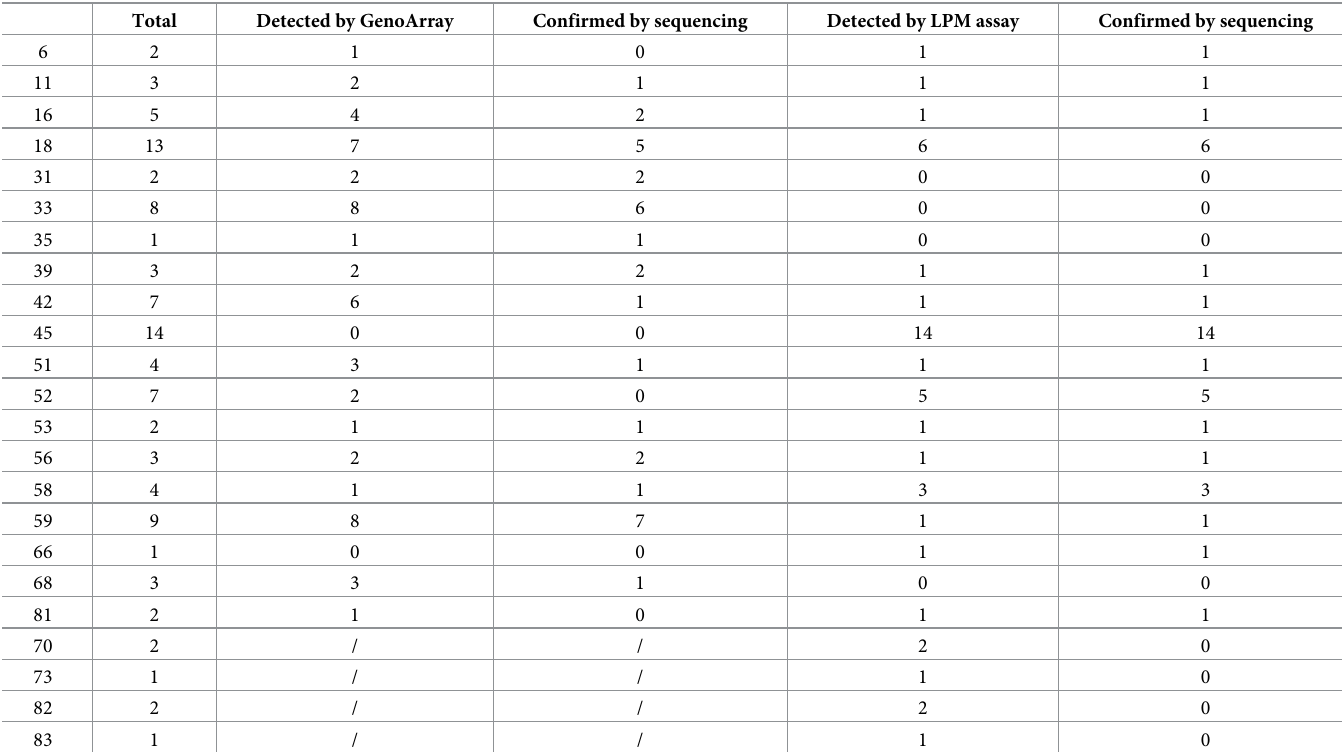
Table 5. Counts of samples with discordant genotypes reassessed by sequencing.